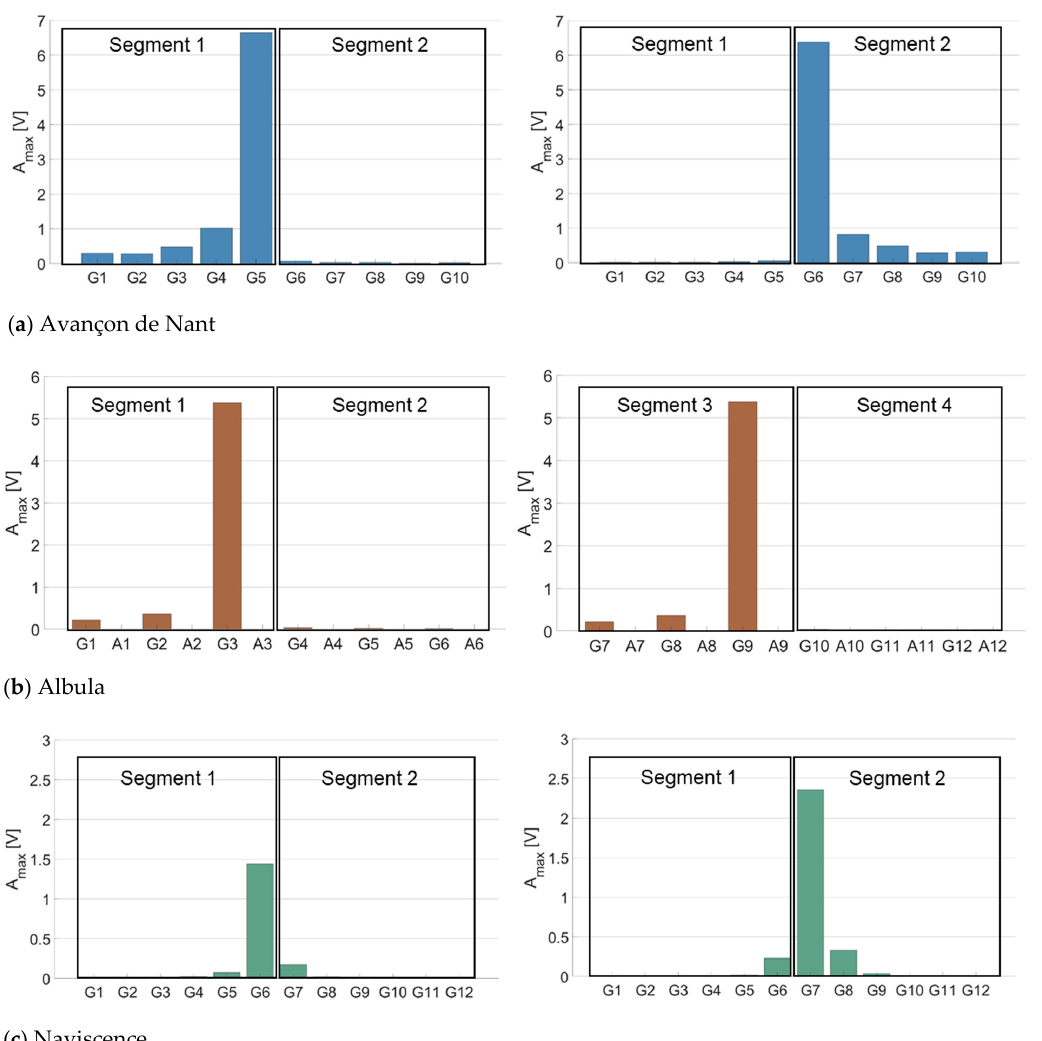
Figure 6. Energy propagation from impacted plates towards non-impacted plates, and across segment limits, at ( a ) the Avançon de Nant, ( b ) the Albula, and ( c ) the Naviscence. Plates located at the margin of different segments have been impacted in this example to illustrate how the energy propagates at the different measuring sites. In this example, one plate per scheme was impacted 10 times (average value) with a weight of 0.256 kg dropped from 0.6 m height (category 9).